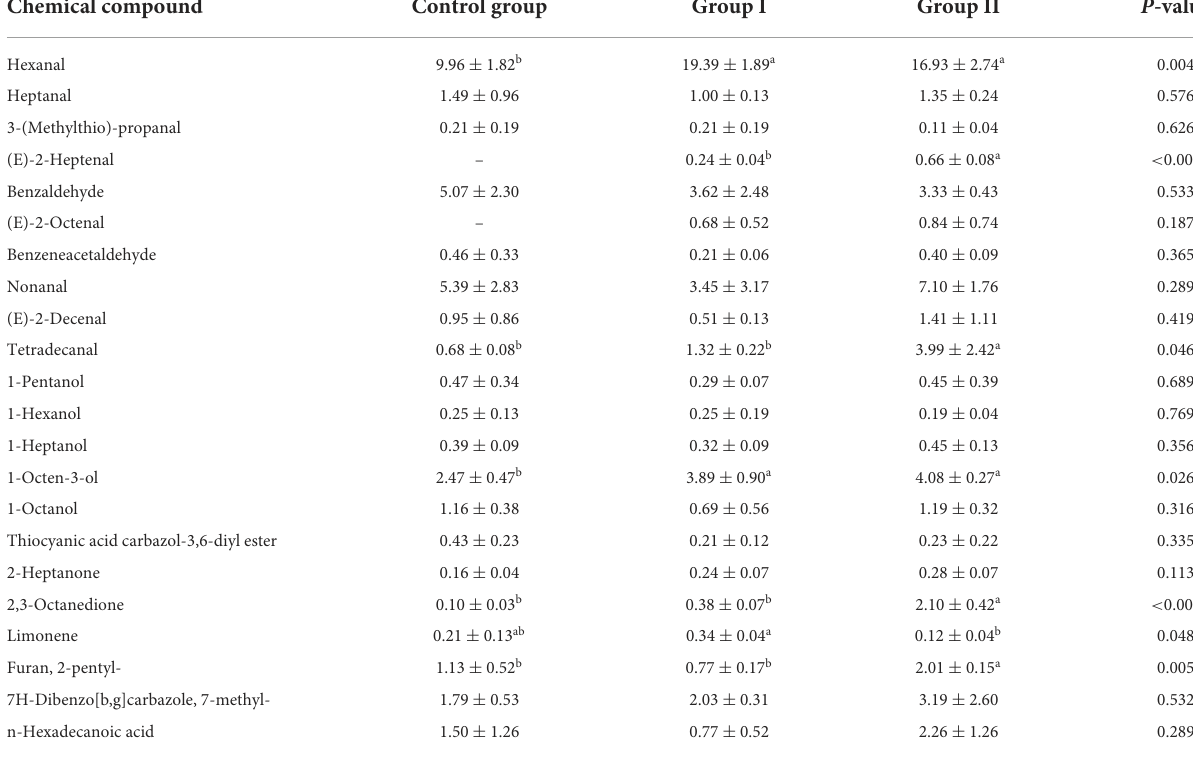
TABLE 12 Effects of dietary protein level on the relative amounts of major volatile compounds in the muscle of finishing pigs (%). Chemical